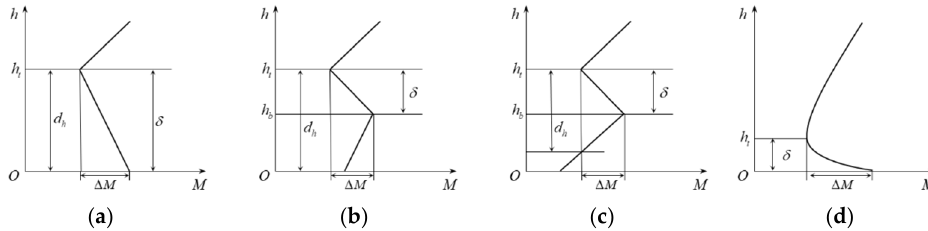
Figure 4. Different types of atmospheric duct: ( a ) Surface duct. ( b ) Surface-based duct. ( c ) Elevated duct. ( d ) Evaporation duct.